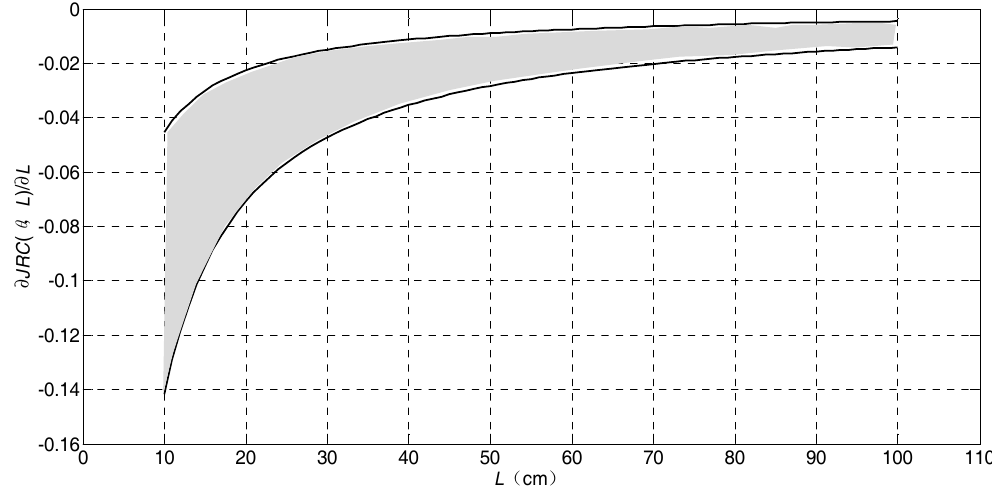
Figure 7. The changing rates of the scale effect.